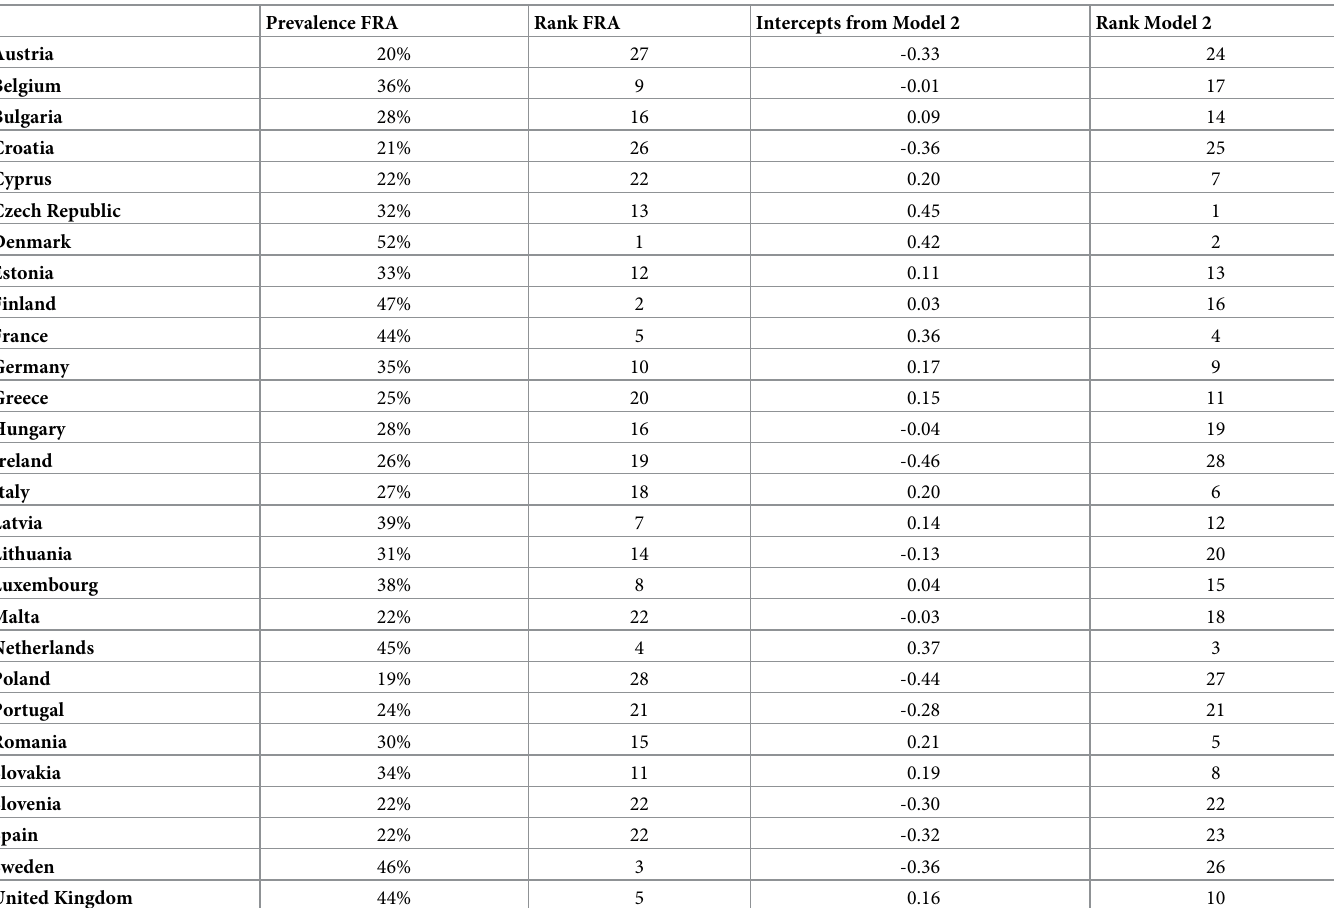
Table 8. Disclosed prevalence rankings comparison.